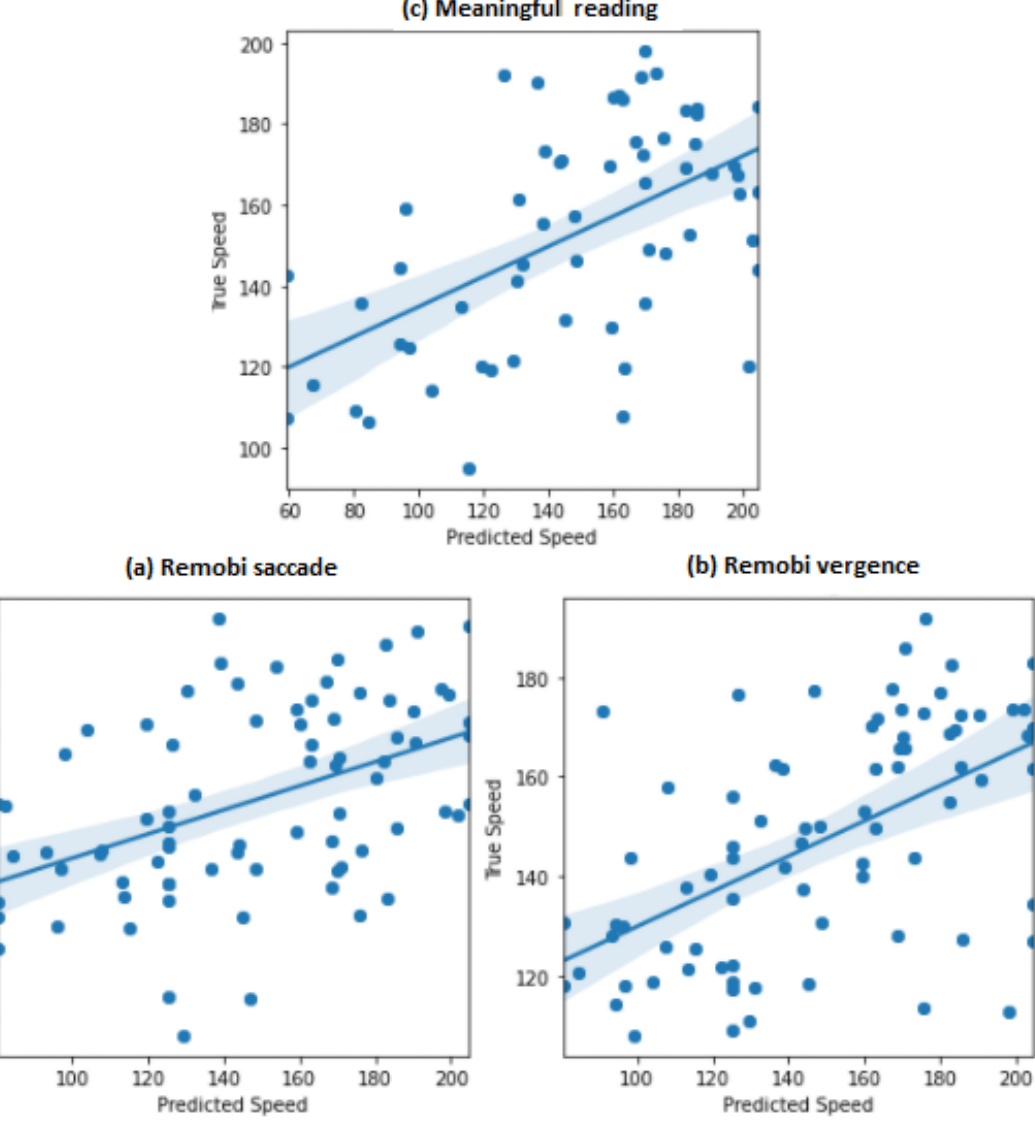
Figure 4. Correlation between true speed vs. predicted speed of the three tasks for the analysis 2: ( a ) Remobi saccade. ( b ) Remobi vergence. ( c ) Meaningful lecture. Table 5. Mean percentage error and correlation metrics for the analysis